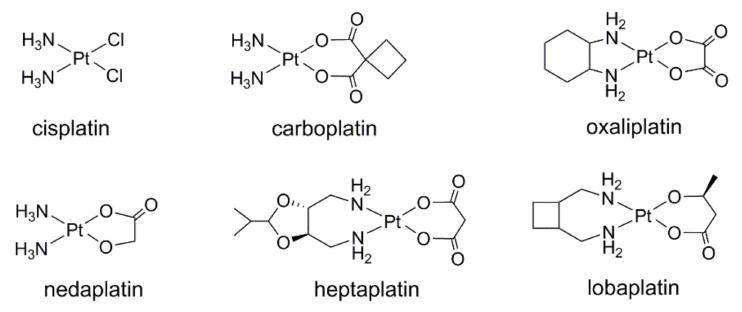
Figure 1. Clinically approved Pt (II) anticancer